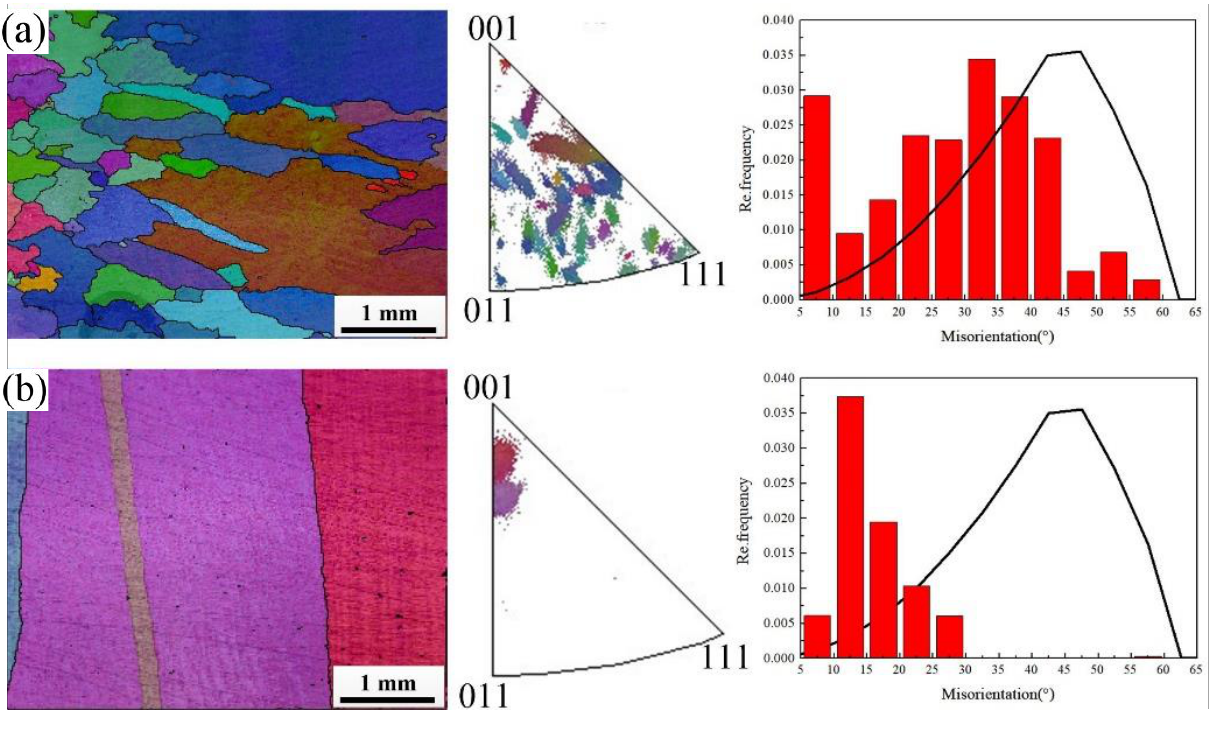
Figure 2. The casting microstructure morphology and crystal misorientation of C70250 copper strips. ( a ) EG strip and ( b ) CG strip.